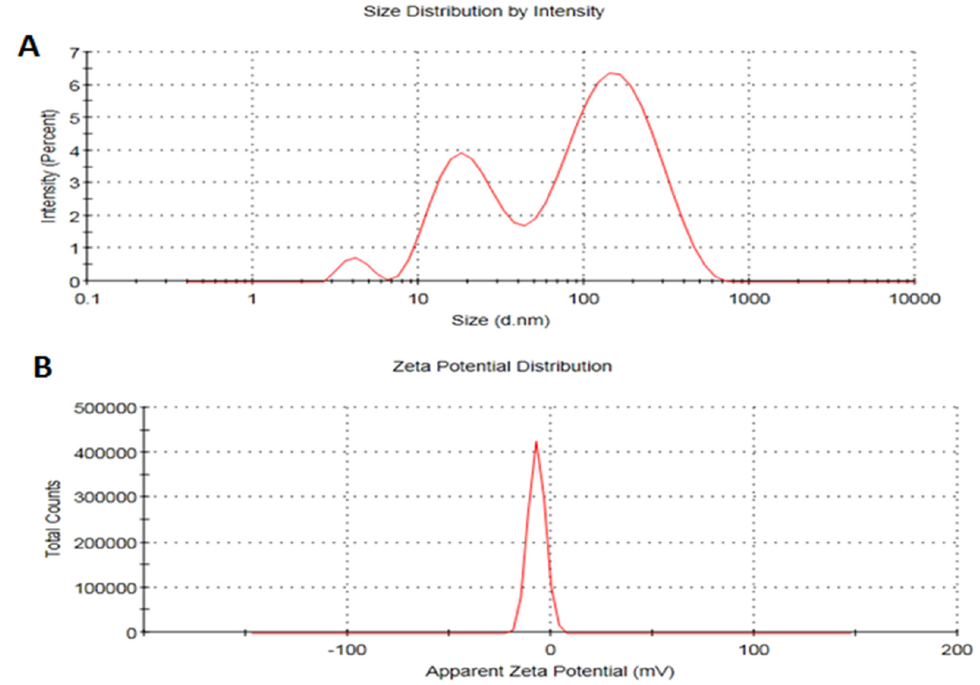
Figure 9. Zeta potential analysis of the biosynthesized ZnO nanoparticles; ( A ) for Size distribution pattern of the biogenic ZnO NPs; ( B ) for Zeta potential analysis of the biosynthesized ZnO NPs. Table 2. Screening of antifungal efficiency of the biogenic ZnO NPs against the tested strains. Concentration ( µ